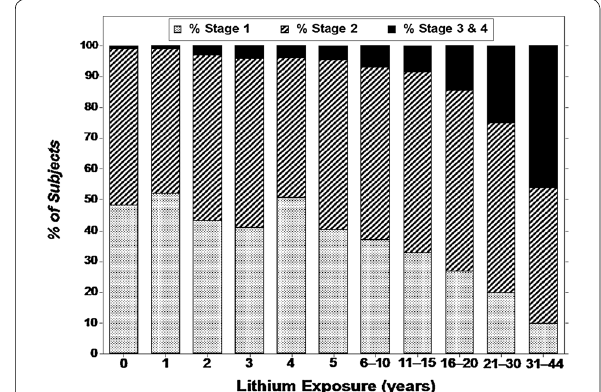
Fig. 1 Proportion (%) of subjects with Stages 1, 2 , or 3 and 4 of renal function vs. years of lithium exposure. By linear regression, the preva‑ lence of Stage 1 renal function (normal) declined highly significantly (slope [ β ]: 1.12 [CI 1.36 to 0.88]; t 10.6, p < 0.0001); Stage 2 − − − = (mild dysfunction) remained stable ( β : –0.035 [CI